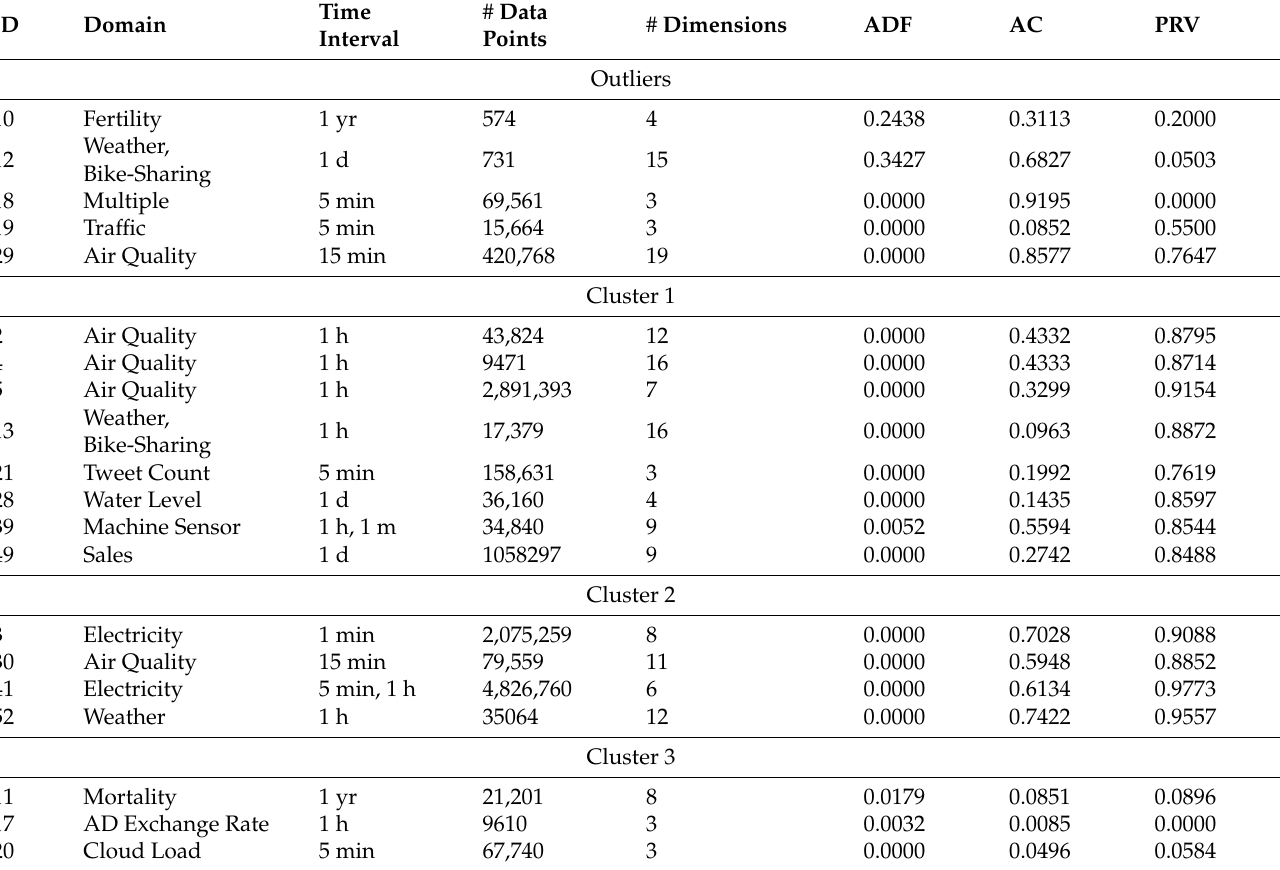
Table 7. Overview of the identified clusters and the corresponding statistical features of the